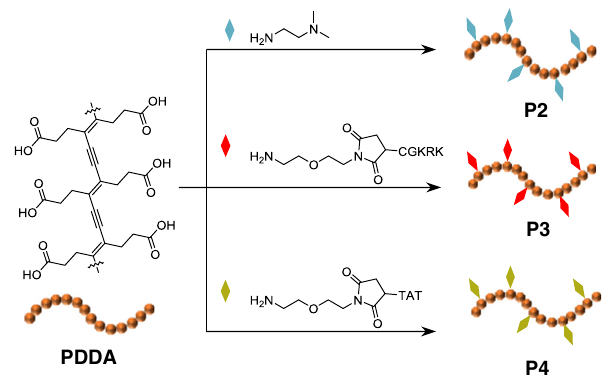
Fig. 5 Side chain modi fi cation of PDDA with different functional groups to derivatives P2, P3, and P4 that can be targeted to speci fi c subcellular organelles. TAT: